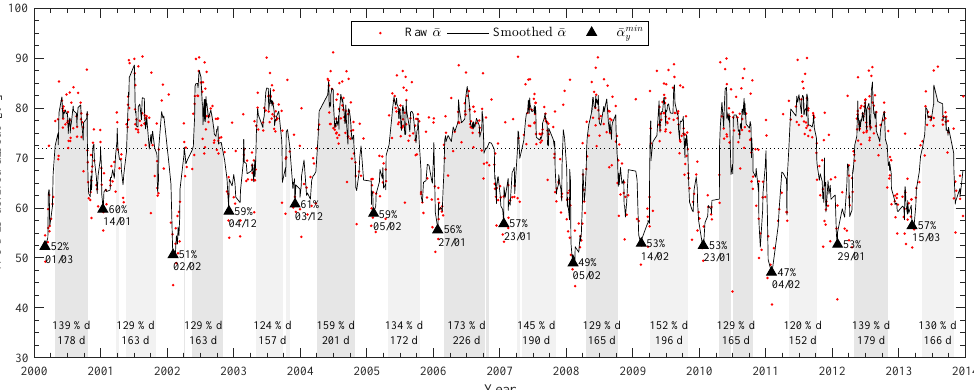
Figure 8. Time-series of MODIS-derived glacier-wide albedo α(t) . The shaded sections indicate the areas under which the signal was integrated to measure the cumulative winter albedo value A yr . The contrasting annual minimum albedo values α min yr are also